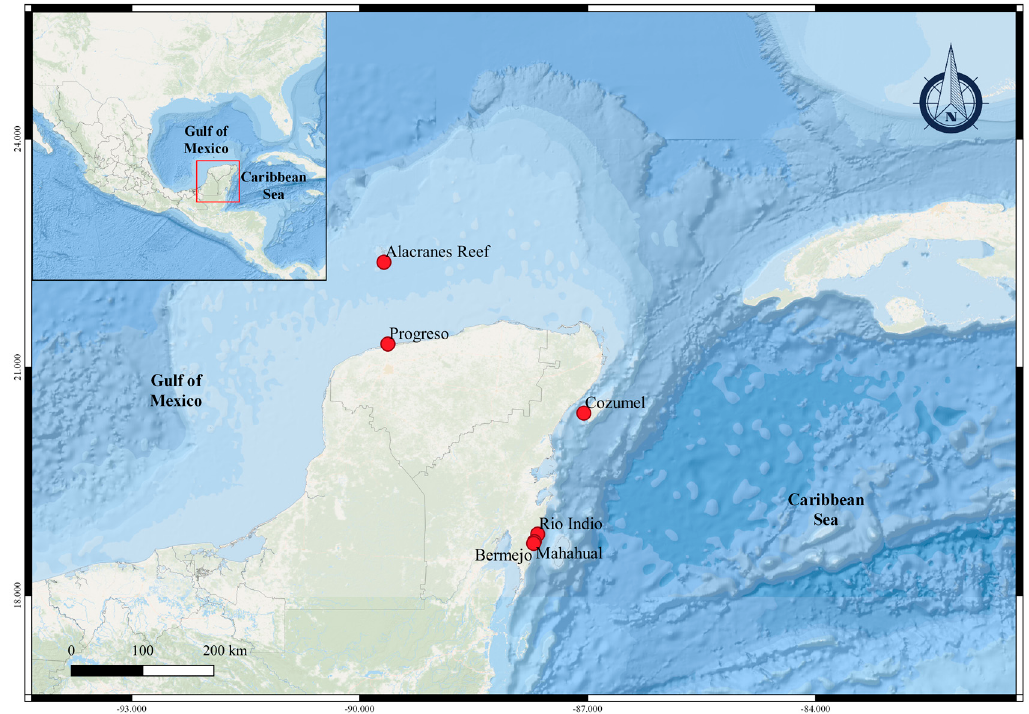
Figure 9. Collection sites of marine organisms in the Yucatan Peninsula, Mexico.